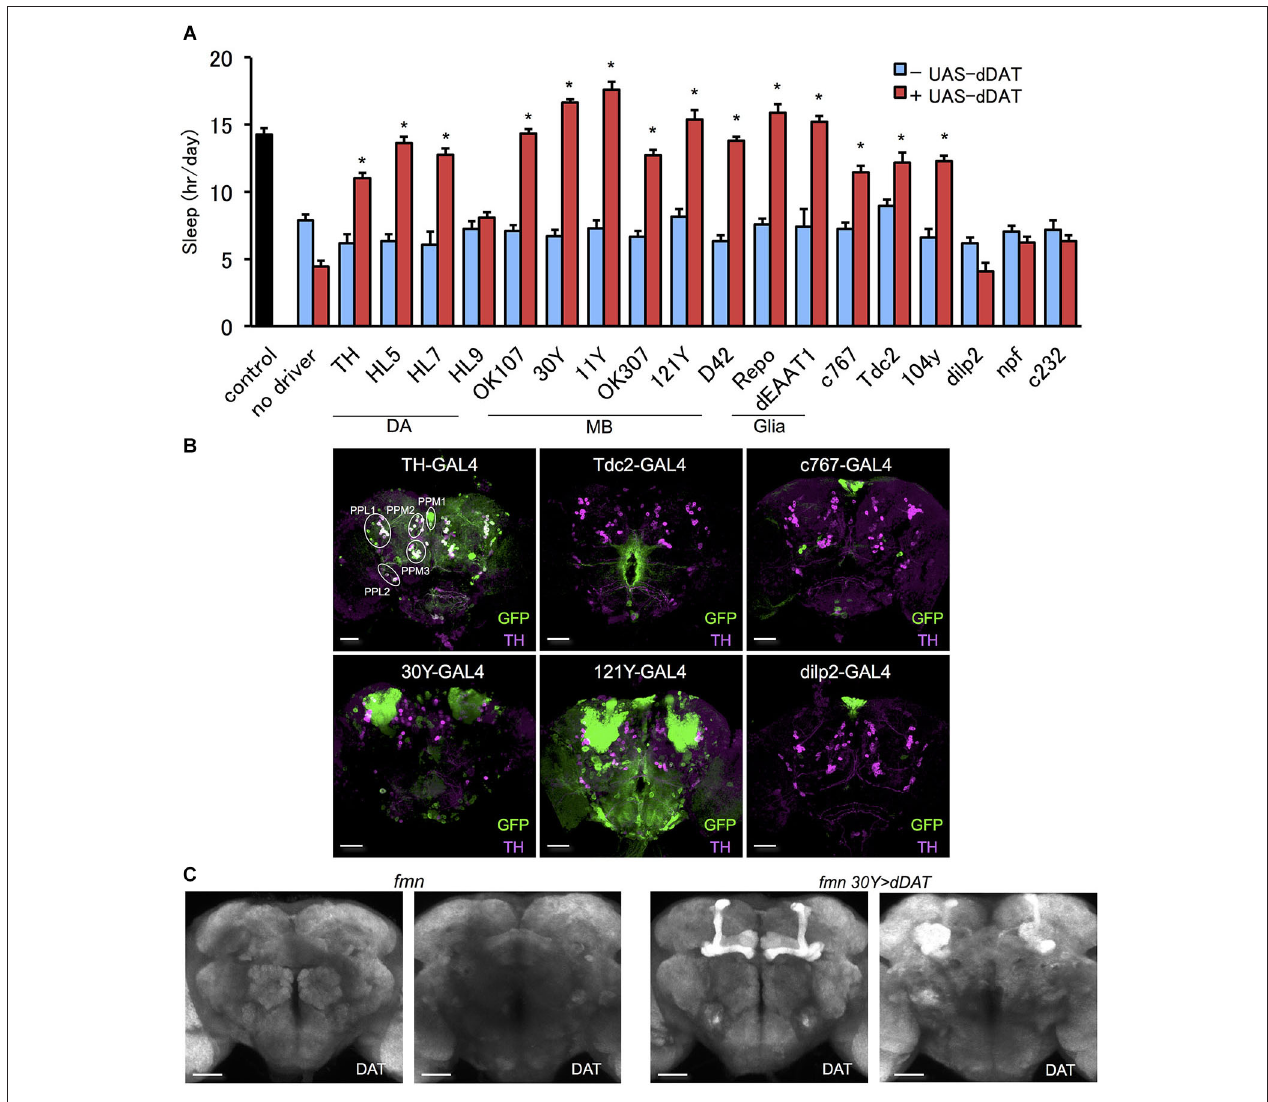
was visualized using UAS-mCD8::GFP (green). Dopamine neurons were visualized using anti-TH antibody counterstaining (magenta). PPM, protocerebral posterior medial; PPL, protocerebral posterior lateral. Scale bars = 50 µ m. (C) dDAT expression in the fly brain detected with immunohistochemistry. dDAT expression in fmn flies and fmn 30Y > dDAT flies are shown. Left panel shows anterior view and right panel shows posterior view. Scale bars = 50 µ m.